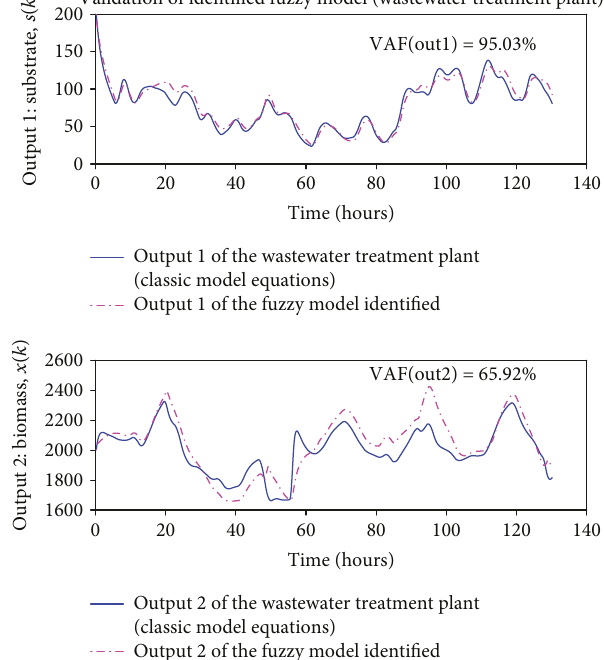
Figure 9: Validation of the identi fi ed fuzzy model corresponding to case C for output 1, s k , and output 2, x k .